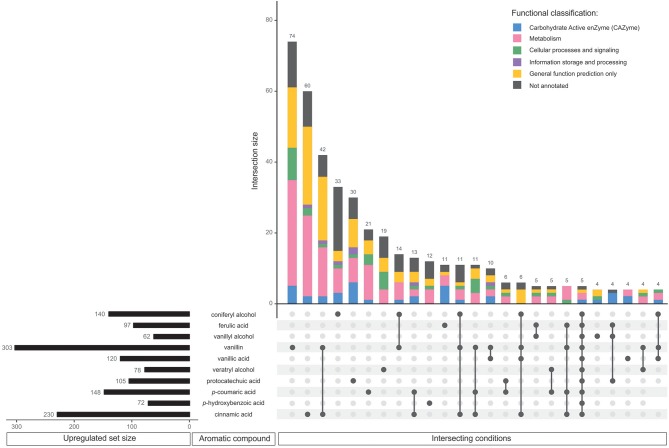
Comparative analysis of all upregulated genes in D. squalens grown in the presence of aromatic compounds. The horizontal bars represent the total number of genes identified as upregulated on the individual aromatic compounds using criteria specified in the Materials and Methods. The vertical bars or intersections represent the number of genes that were regulated by one or more aromatic compounds (intersecting conditions). The intersections were organized by size and top 25 sets with the highest number of genes were presented. The genes in each intersection were color-coded according to their predicted functional classification.